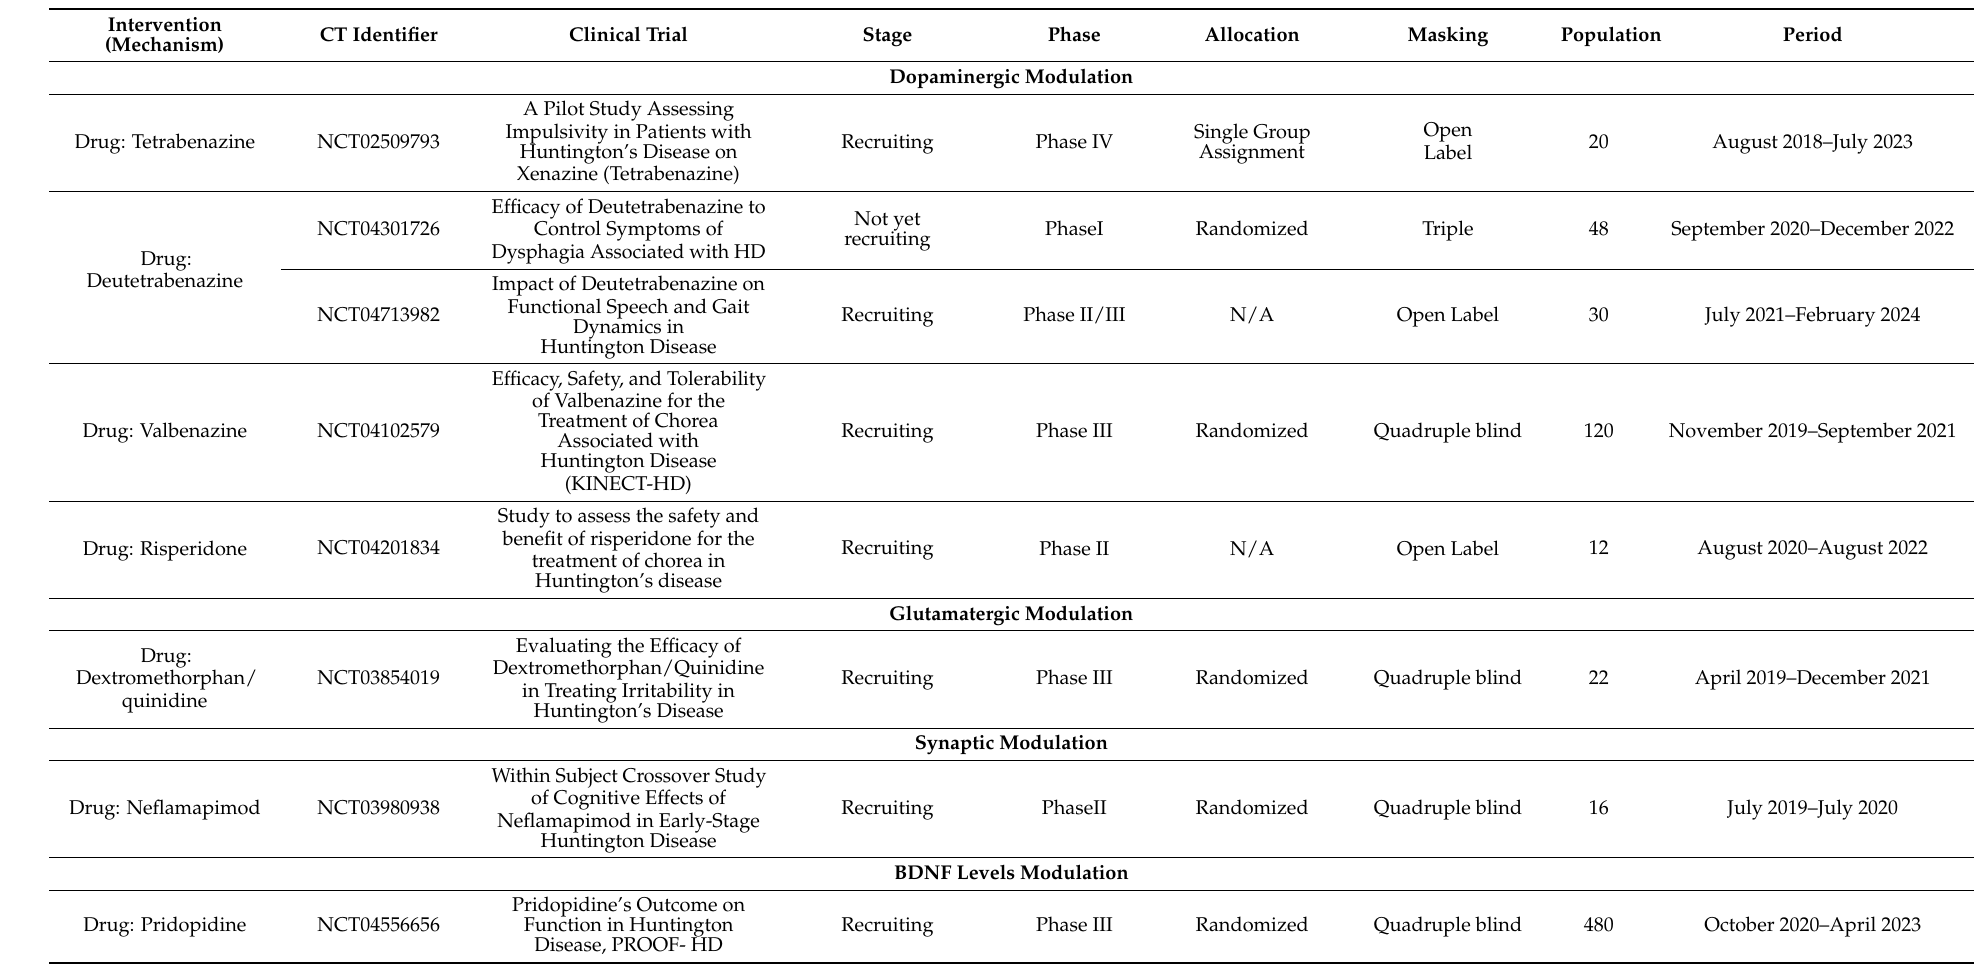
Table 1. Clinical trials for Huntington’s disease (HD) currently active and/or recruiting participants registered at Clinicaltrials.gov (accessed on 2 July 2021). Intervention